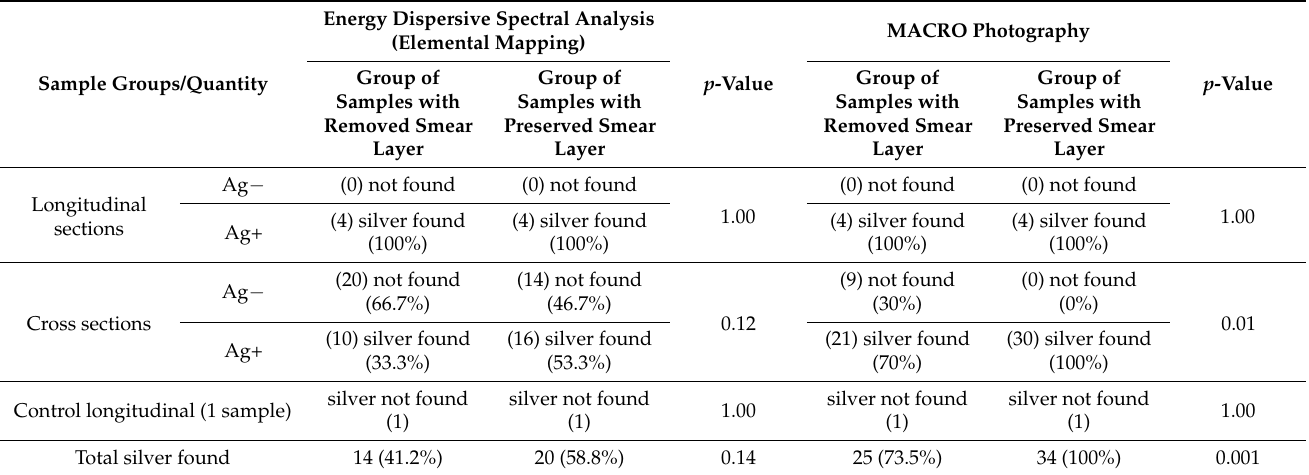
Table 3. Results of silver detection in groups of samples with removed and preserved smear layer.